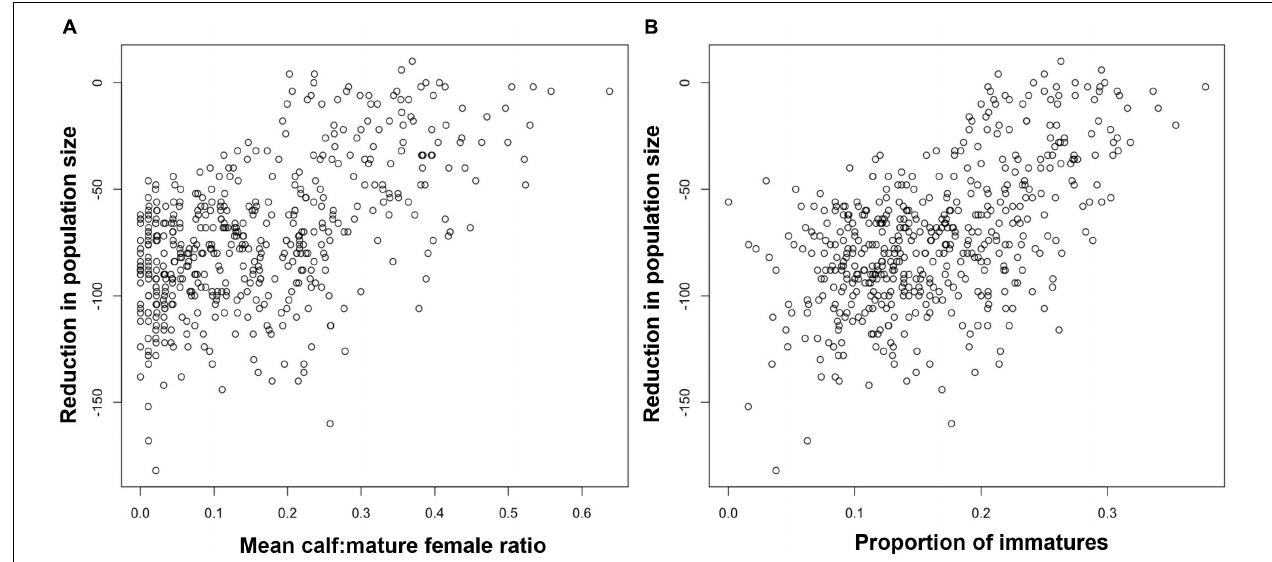
FIGURE 4 | Relationship between the maximum predicted reduction in bottlenose dolphin population size and (A) the average ratio of calves to mature females in the first 3 years of disturbance, (B) the proportion of immature animals in year 5 when environmental variation and demographic stochasticity was included in the